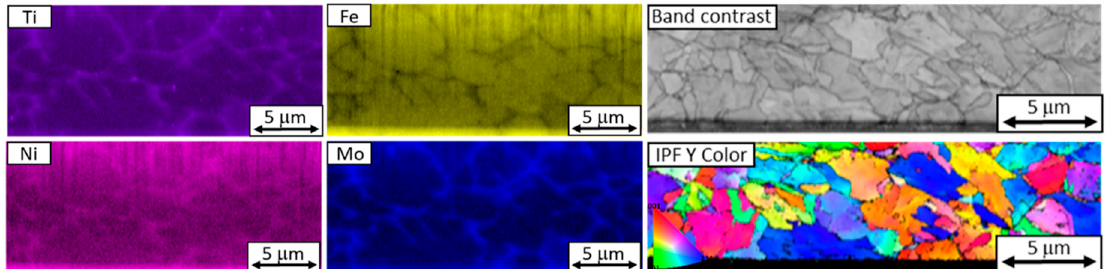
Figure 6. EDS maps of virgin powder particles. ( a ) A larger particle with a diameter of 38 μ m with a partially etched microstructure, ( b ) a smaller particle, 16.5 μ m in diameter.